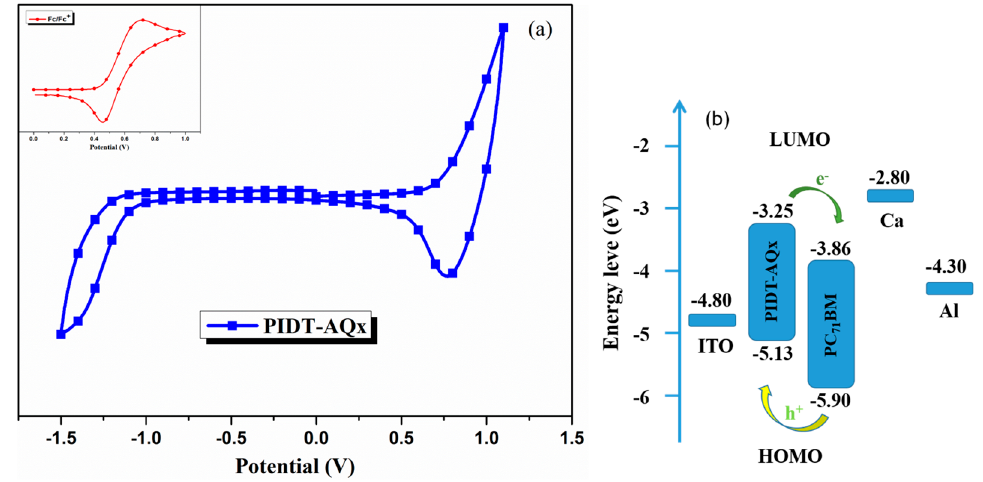
Figure 3. ( a ) The cyclic voltammetry of PIDT-AQx film and ( b ) the schematic energy levels of the PIDT-AQx, PC 71 BM and cathodes (Ca, Al). Table 1. Optical and electrochemical properties of PIDT-AQx.